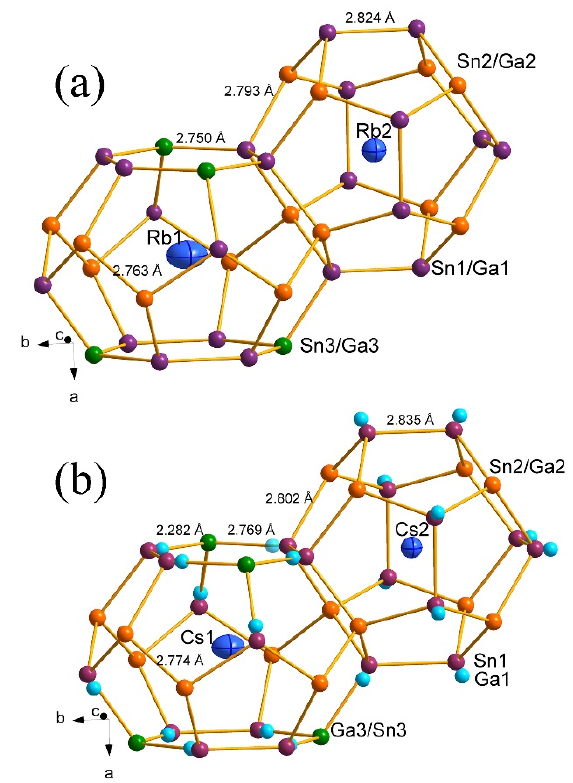
Figure 2. Fragments of the structure of ( a ) Rb 8 Ga 7.1(1) Sn 38.9 and ( b ) Cs 8 Ga 7.5(1) Sn 38.5 . Sn1 / Ga1 (Sn1 for Cs 8 Ga 7.5(1) Sn 38.5 ), Sn2 / Ga2, Sn3 / Ga3, (Ga1 for Cs 8 Ga 7.5(1) Sn 38.5 ) atoms are drawn as plum, orange, green, and light blue respectively. Displacement ellipsoids for guest atoms Rb and Cs atoms (blue) are shown at the 95% probability.